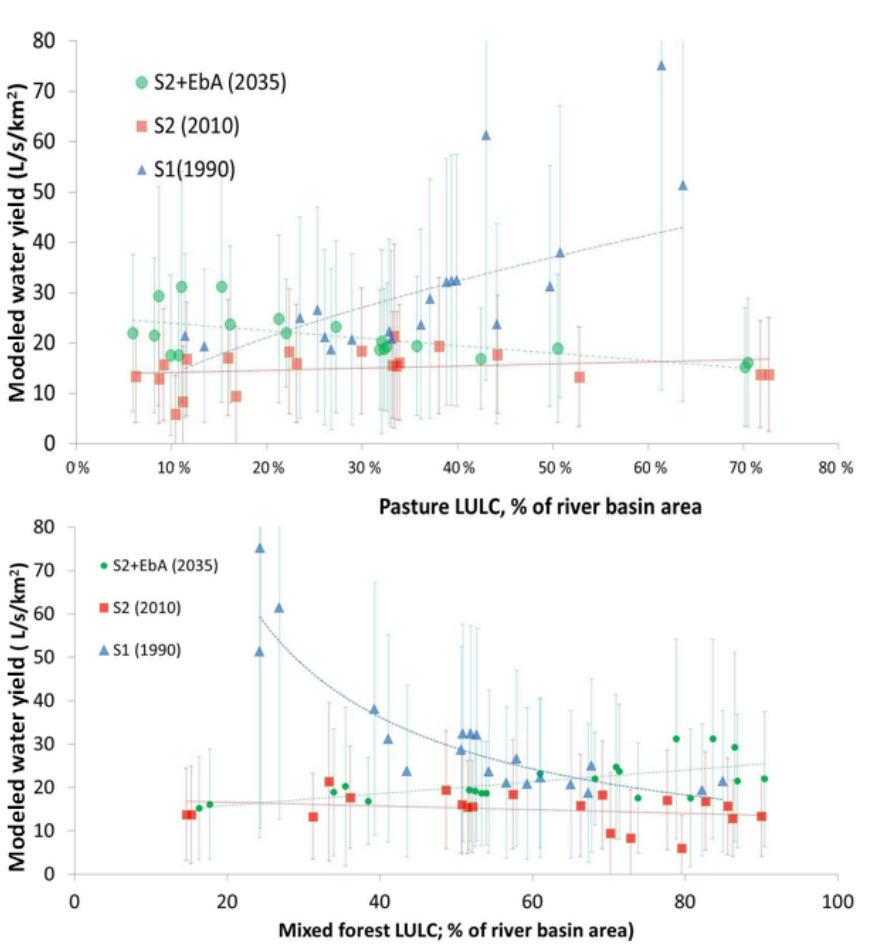
Figure 11. LULC scenarios for specific water yield for 20 drainage areas at Jaguari, Cachoeira and Atibainha watersheds, according to S1 (1990), S2 (2010) and S2 + EbA (2035)